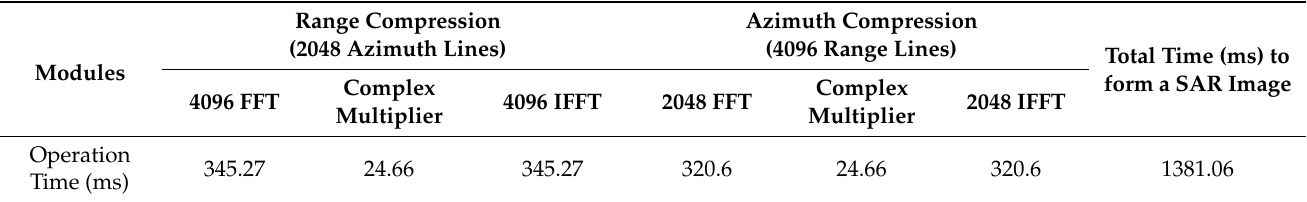
Table 2. Timing performances of the proposed SAR processor.